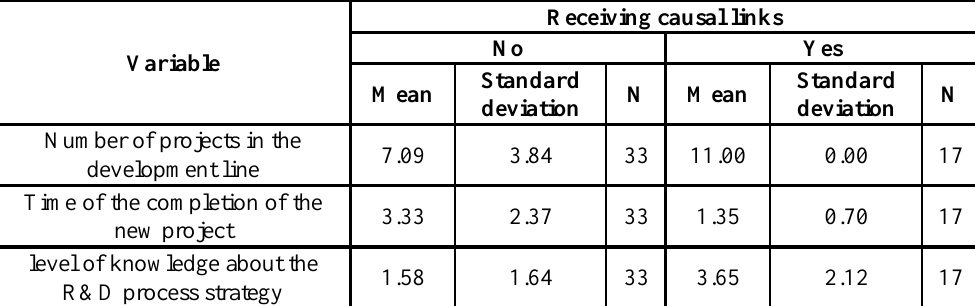
Table 11. Descriptive statistics (receiving complementary causal links)